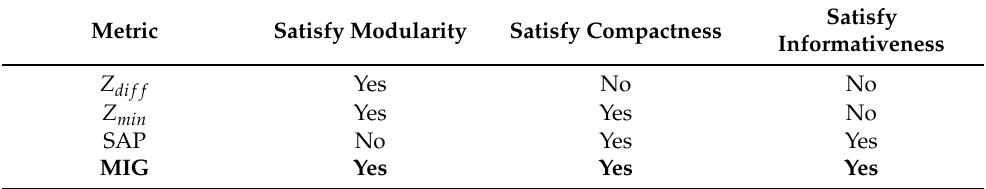
Table 5. Summary of our findings from metric comparison. We found that most of the existing metrics can either satisfy modularity, compactness or informativeness criteria, except for the Mutual Information Gap score that captures all the three properties of a